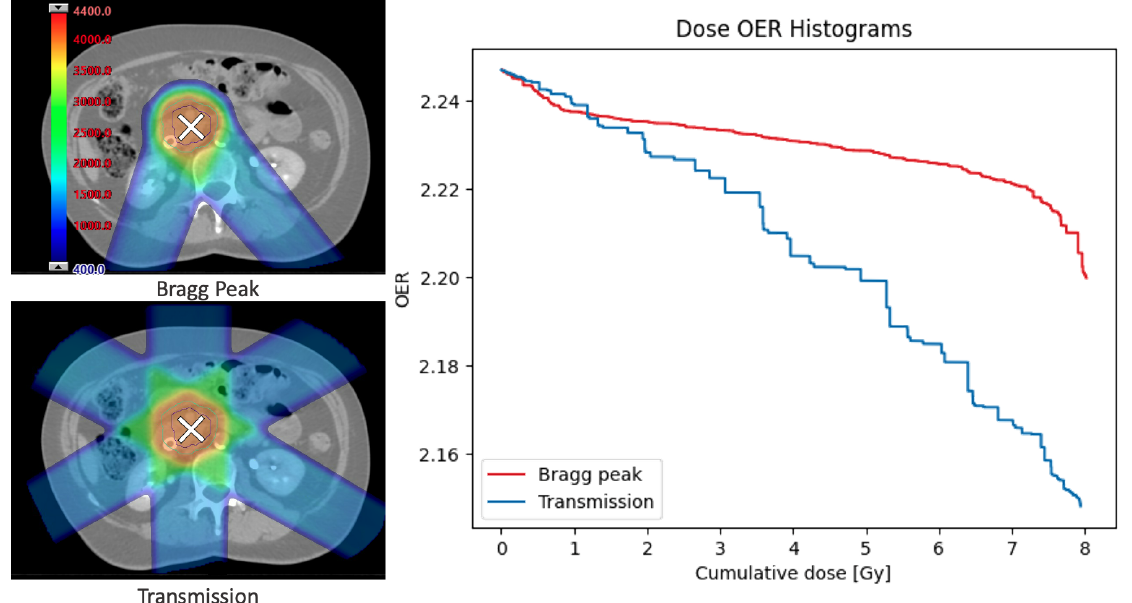
Figure 4. Non-clinical dose distributions ( left ) generated to deliver 8 Gy per fraction to the same abdominal treatment site using either multiple layers of Bragg peaks ( top left ) or 245 MeV transmission beams ( bottom left ). Example dose-OER histograms ( right ) were calculated for a single point in the PTV of both plans, to show the OER as as a function of cumulative dose at that point. The area under the OER curve gives an indication of the overall decrease in radiosensitivity during the plan. Results were generated for the node 25µm from the